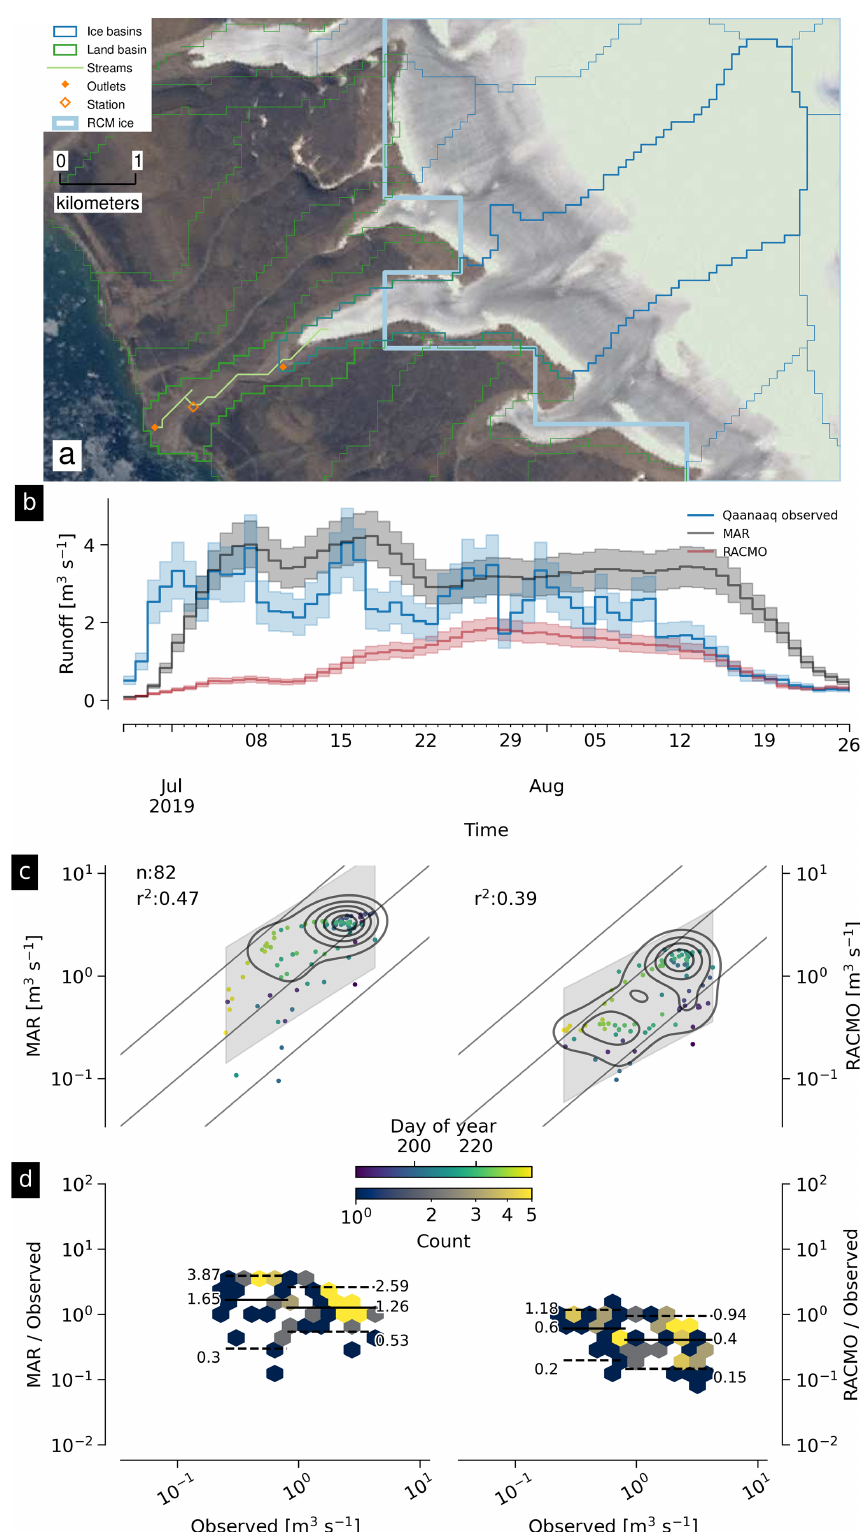
Figure 17. Graphical summary of Qaanaaq outlet, basin, and discharge (Q in Fig. 1). See Sect. 3.4 for a general overview of graphical elements and Sect. 4.2.6 for discussion of the Qaanaaq basin. Basemap from Howat et al. (2014) and Howat (2017a).